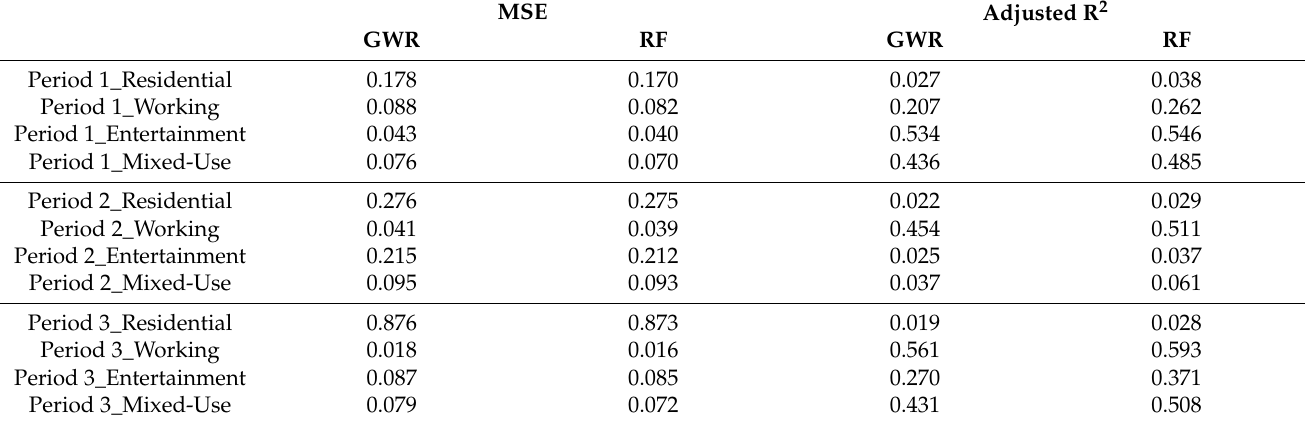
Table 2. The comparison of the accuracy of